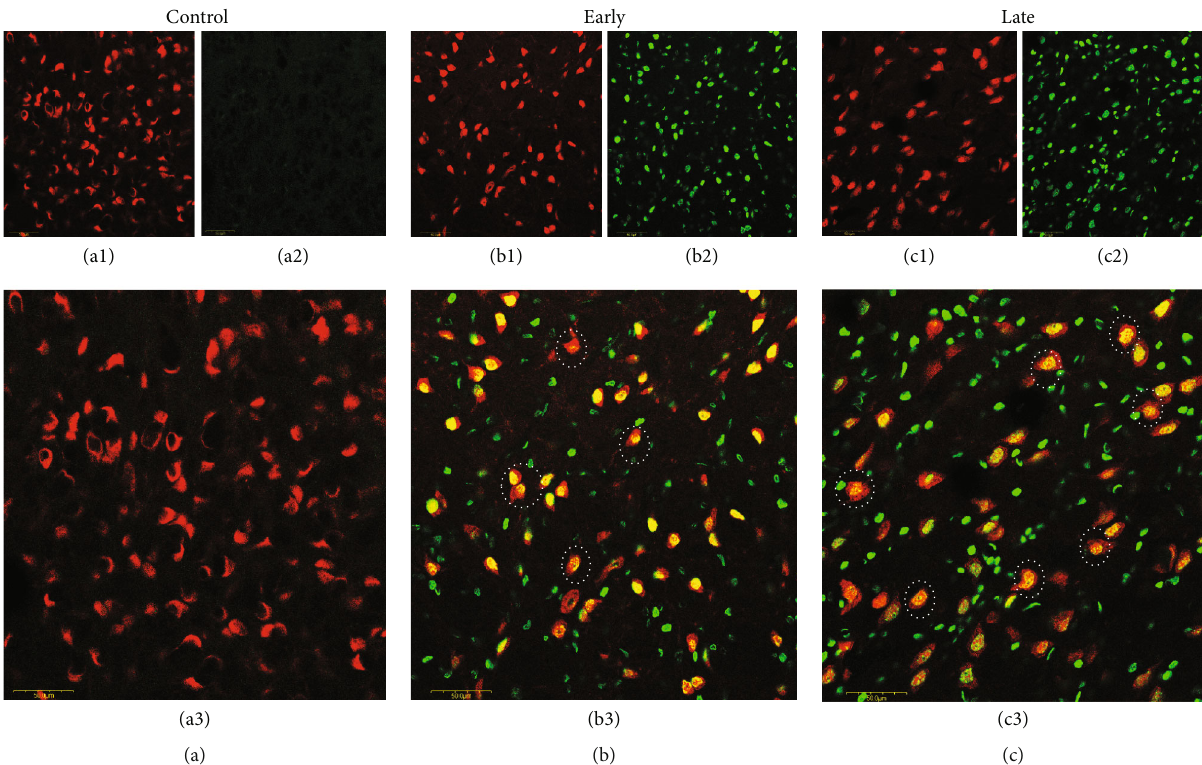
Figure 6: Prenatal opioid exposure induced cell apoptosis in the ventral-medial striatum of neonatal rat o ff spring (P14). Colocalization of NeuN- (red for neuron identi fi cation) and TUNEL- (green for apoptotic cells) sensitive cells was recognized by double immuno fl uorescence staining with laser-scanning confocal microscopy. The NeuN-sensitive cells (panel 1), TUNEL-sensitive cells (panel 2), and the combined pictures of the NeuN- and TUNEL-sensitive cells (panel 3) are as follows: the control (a1 – a3), the early group (b1 – b3), and the late group (c1 – c3), respectively. The dotted circles reveal representative apoptotic neurons. Bar = 50 μ